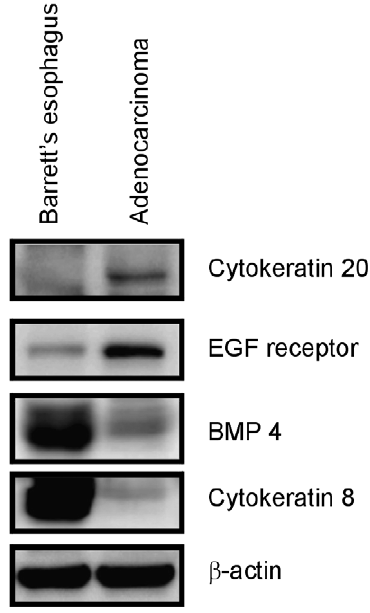
Fig. 3. Immunoblot validation of SAGE results of esophageal ade- nocarcinoma and Barrett’s esophagus. Immunoblot analysis on pro- tein samples from esophageal adenocarcinoma and Barrett’s eso- phagus biopsies from different patients reveals that Cytokeratin 20 and EGF-receptor are highly expressed in esophageal adenocarci- noma (EA) and lower in Barrett’s esophagus (BE). Furthermore BMP4 and Cytokeratin 8 are highly expressed in Barrett’s esophagus and lower in esophageal adenocarcinoma. Pictures are representative for results of 10